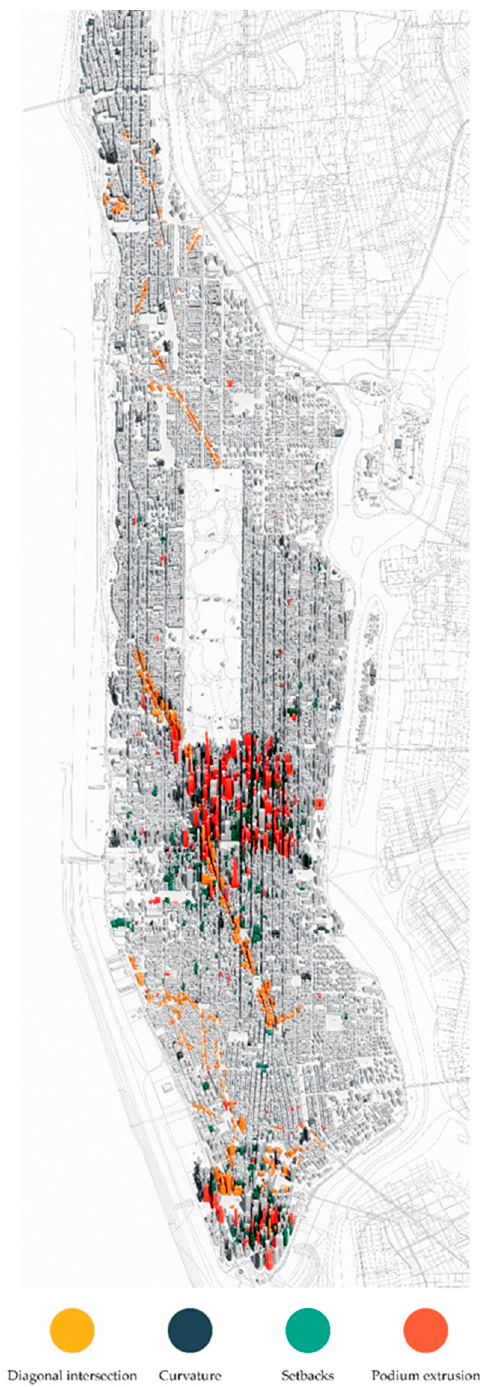
Figure 2. Geographic variation of external architectural design features. Figure 2 depicts the geographic variation of external architectural design features—diagonal intersection, curvature, setbacks and podium extrusions have their building geometry highlighted across Manhattan, New